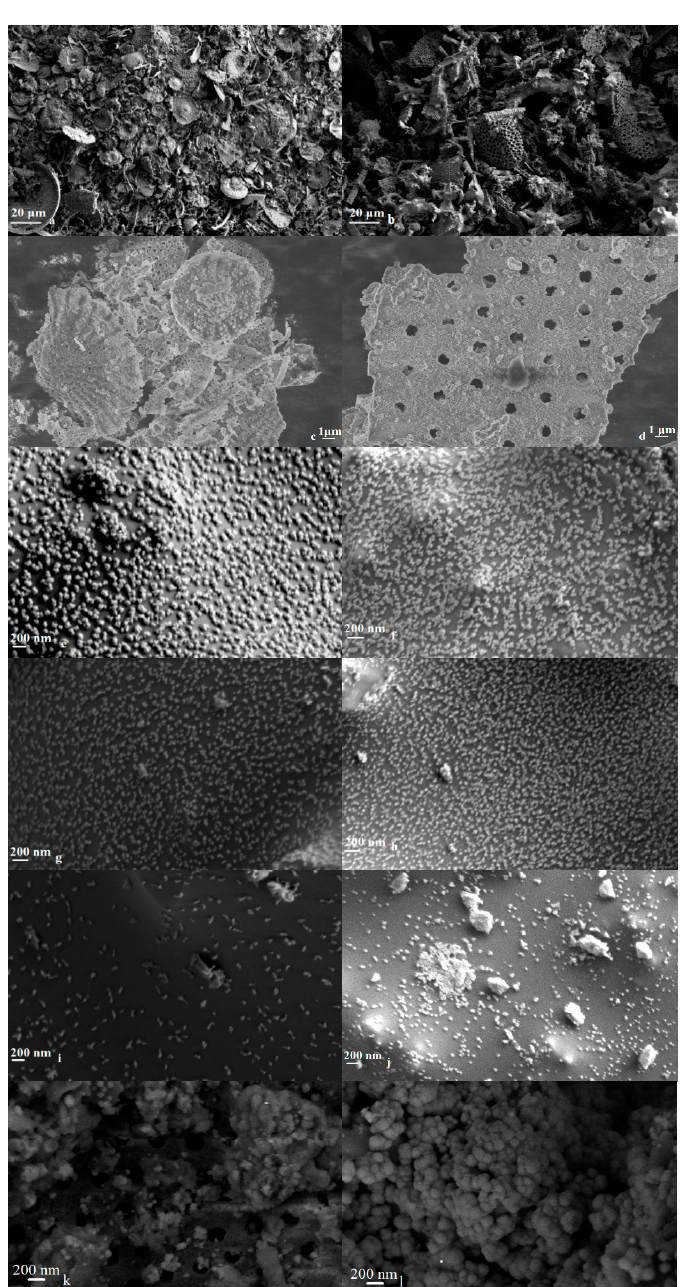
Figure 2. SEM images of ( a ) natural diatomite, ( b ) food-grade diatomite, catalysts calcined at 250 °C, including ( c ) Mn x Co y /N low magnification, ( d ) Mn x Co y /F low magnification, ( e ) Mn 10 Co 15 /N, ( f ) Mn 10 Co 15 /F, ( g ) Mn 10 Co 5 /N, ( h ) Mn 10 Co 5 /F, ( i ) Mn 5 Co 5 /N, and ( j ) Mn 5 Co 5 /F and used catalysts, including ( k ) Mn 10 Co 15 /N; ( l ) Mn 10 Co 15 /F.